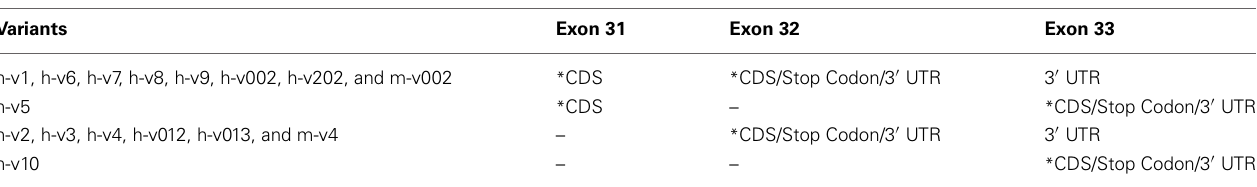
Table 2 | Alternative splicing at the extreme COOH-terminus of